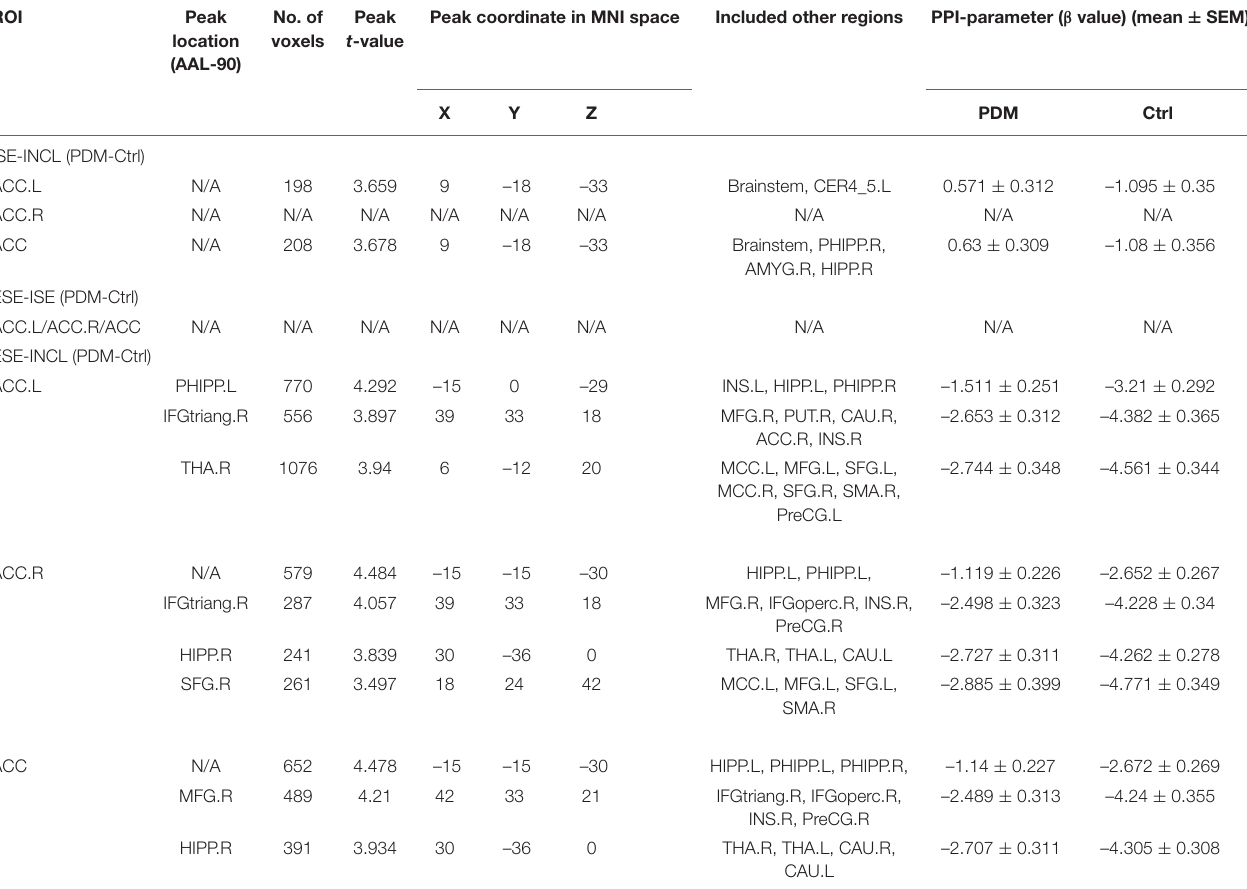
TABLE 3 | Specific brain regions show significant group differences in functional connectivity with ACC.L/ACC.R/ACC for ISE-INCL, ESE-ISE, ESE-INCL contrasts.